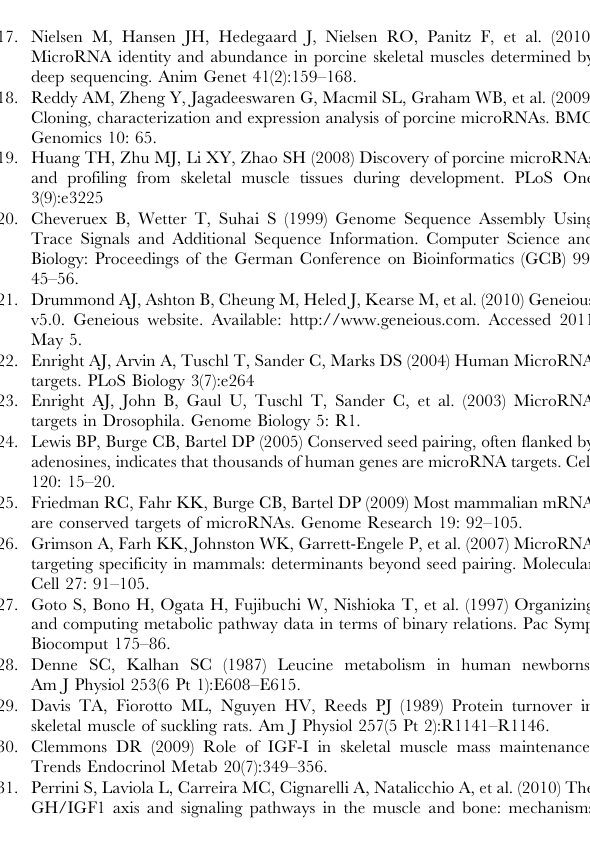
Table S4 Overlap of 3 9 UTR that contain predicted miRNA binding sites. 3 9 UTR expressed in porcine skeletal muscle were evaluated to computationally identify miRNA binding sites with MiRanda and TargetScan. Overlap of 3